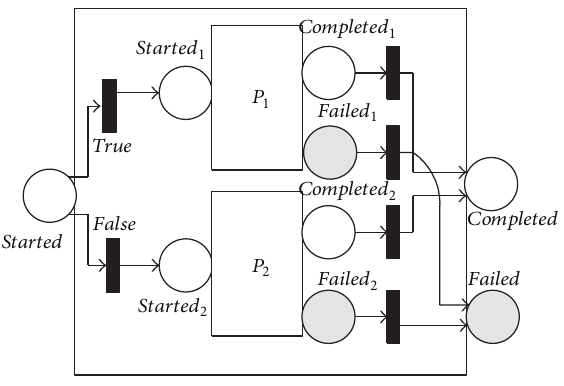
Figure 6: NMSPN model of the if-then-else